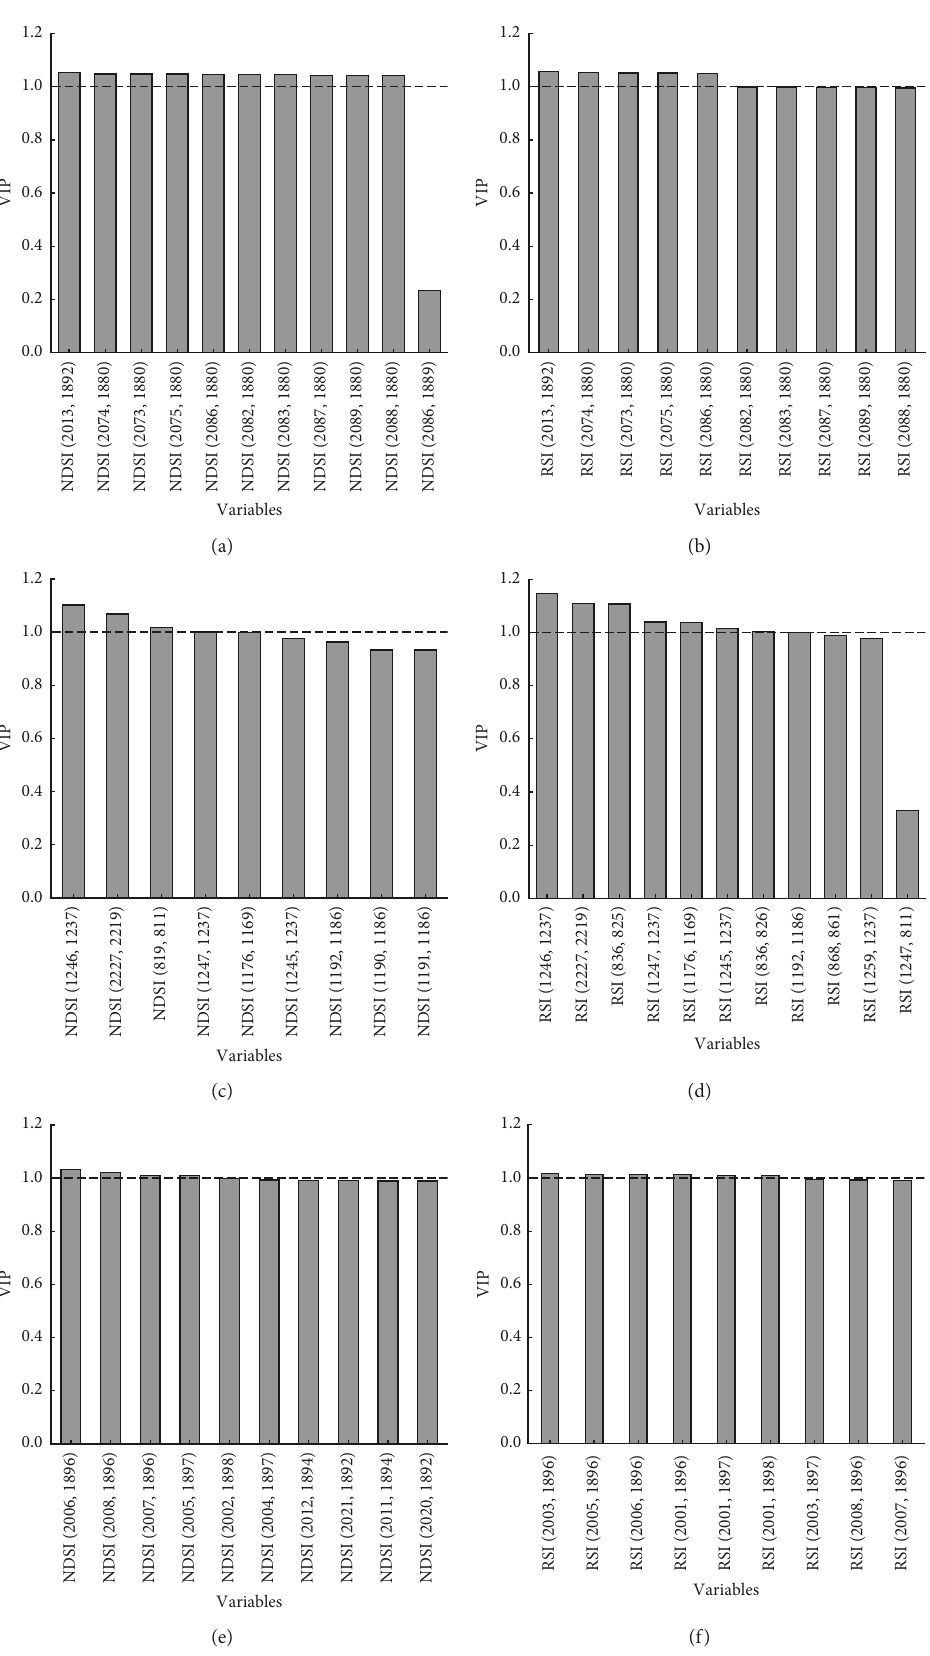
Figure 4: Bar chart of the model parameters (VIPs). (a) NDSI-Ebinur Lake Basin. (b) RSI-Ebinur Lake Basin. (c) NDSI-Ugan-Kuqa Oasis. (d) RSI-Ugan-Kuqa Oasis. (e) NDSI-Keriya Oasis. (f) RSI-Keriya